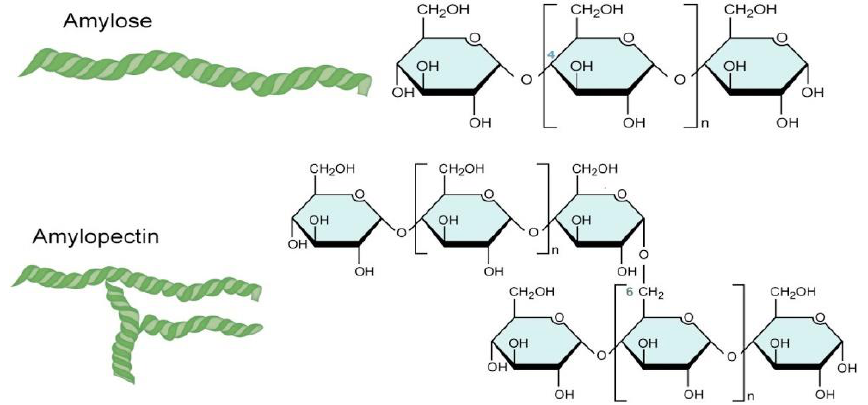
Figure 2. Structure of amylose and amylopectin in starch. Reprinted with permission from Ref. [28]. Copyright 2015 Elsevier Ltd.